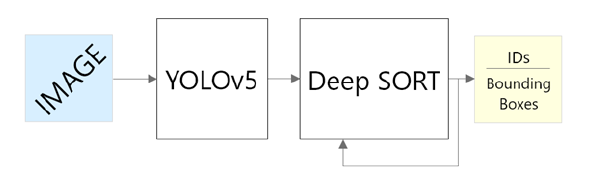
Figure 3. The general architecture showing the distinct components of the system. An image is fed to YOLOv5, and detections are passed to the DeepSORT tracking algorithm. IDs and bounding boxes are retained as the object is tracked.